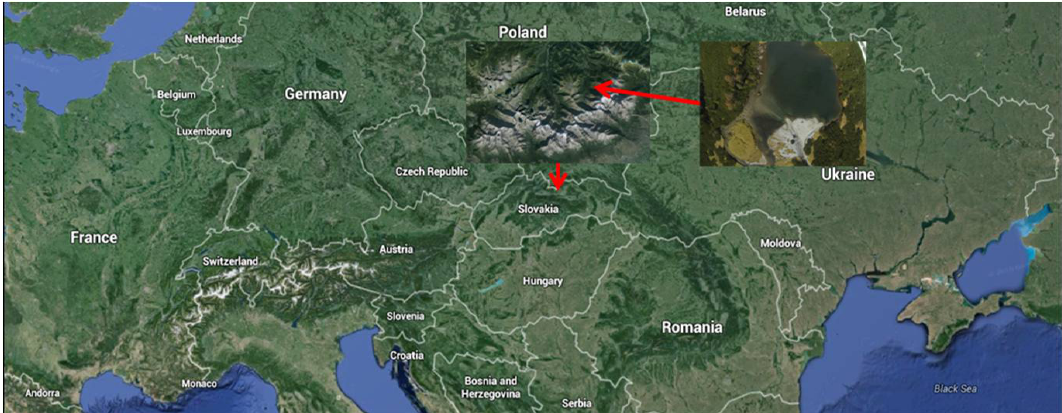
Figure 2. Location of the study